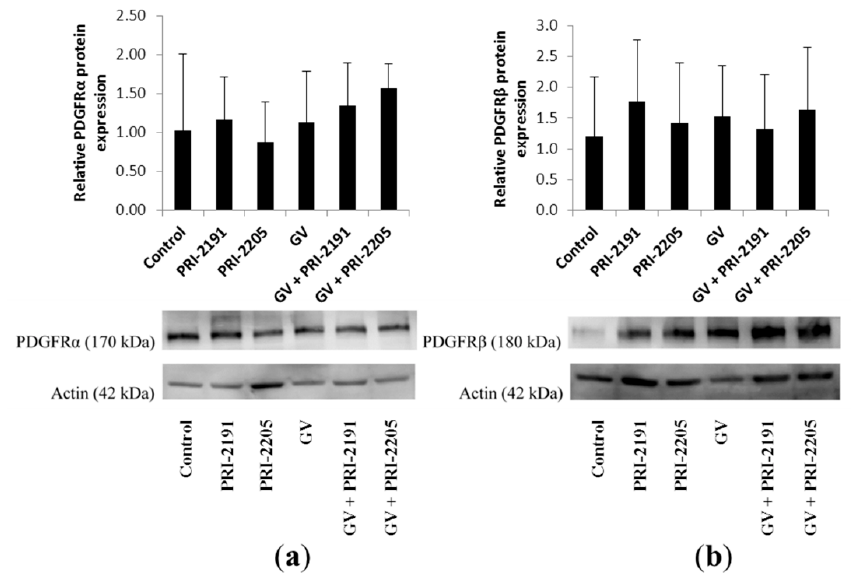
Figure 6. ( a ) PDGFR α and ( b ) PDGFR β expression in A549 lung cancer tumor tissue determined by Western blot: immunoblot and densitometric analysis (mean ± SD). GV, imatinib; PRI-2191 and PRI-2205, vitamin D analogs.